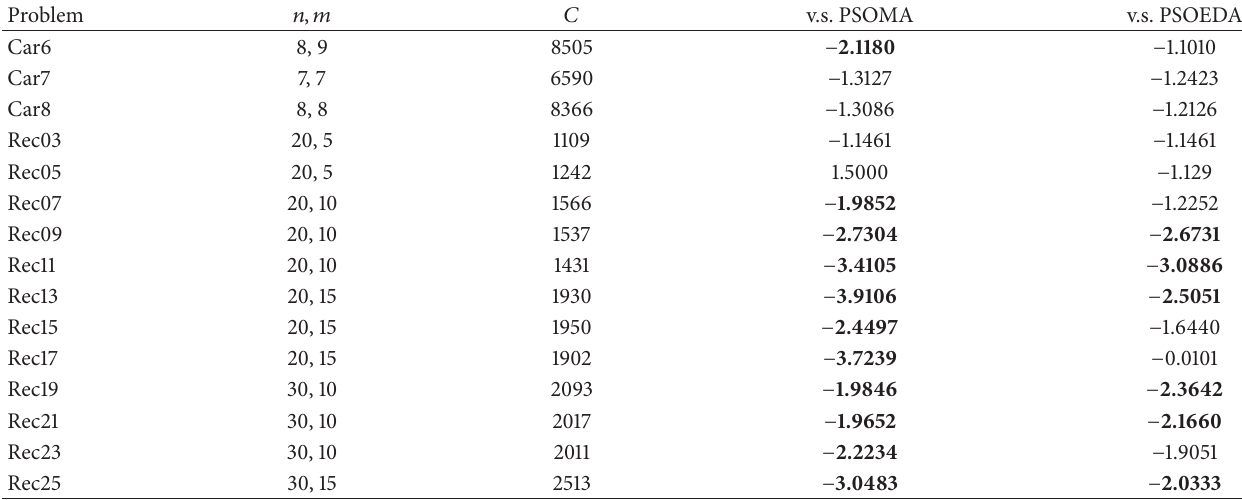
Table 4: The results of Wilcoxon matched-pairs signed-rank test of MPSOMA with PSOMA and PSOEDA.